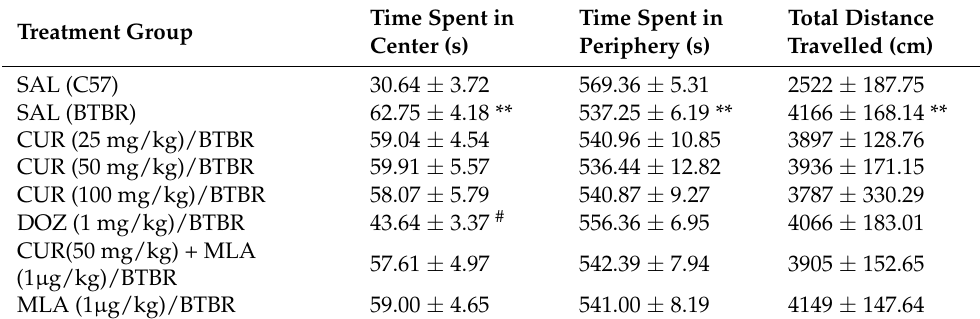
Table 1. Effects of curcumin and donepezil systemic pretreatment on anxiety levels and locomotor activity in BTBR